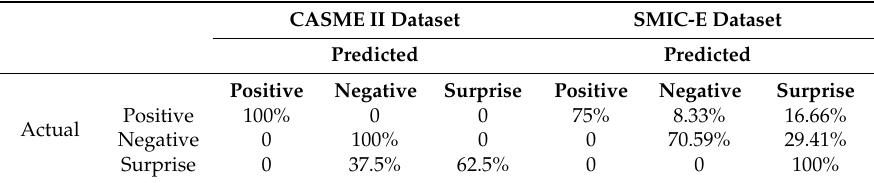
Table 4. Recognition confusion matrices on the CASME II and SMIC-E